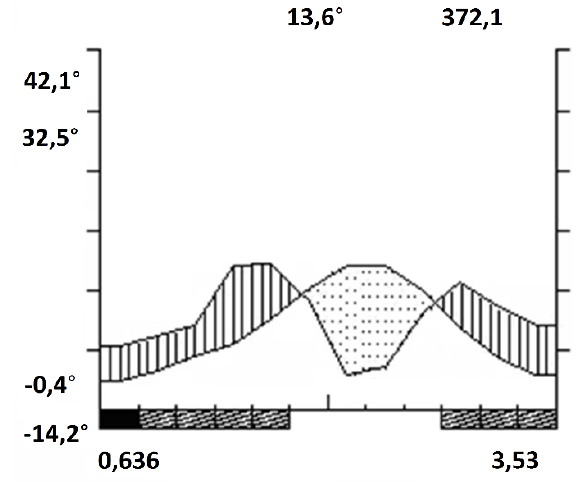
Figure 2. Climate diagram by Walter and Lieth of the “Albacete-Los Llanos” climatic station. In the diagram, 20 mm of monthly precipitation (right ordinate) is equal to 10 °C average temperature (left ordinate); when the precipitation curve undercuts the temperature curve, the area between them is dotted indicating the dry season (3.53 months); when the precipitation curve supersedes the temperature curve, vertical lines are plotted indicating moist season; the diagram shows in black bars below the horizontal axe the frost period (January); the climate diagram was performed utilizing the software Climoal ®